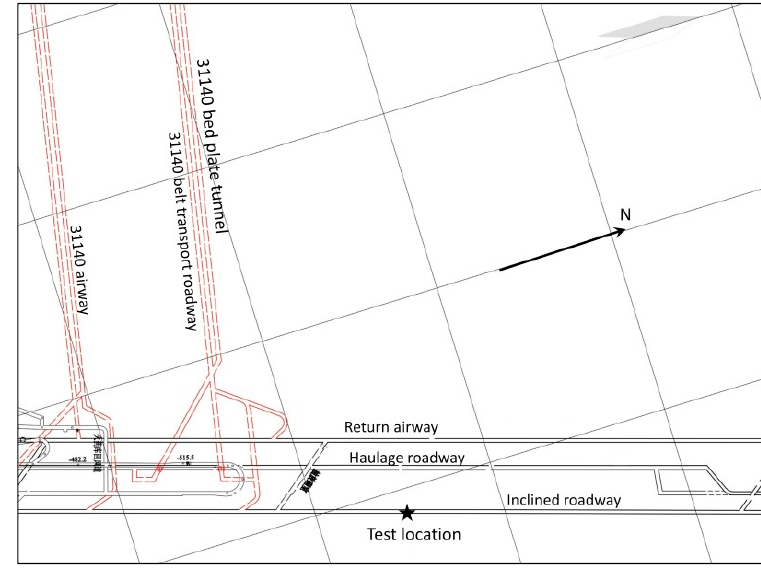
Figure 7. Roadways distribution of test location in PDS No. 1 coal mine.